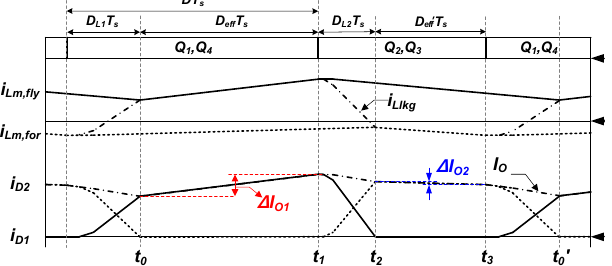
Figure 9. Primary and secondary current waveforms of proposed converter neglecting the dead-time.